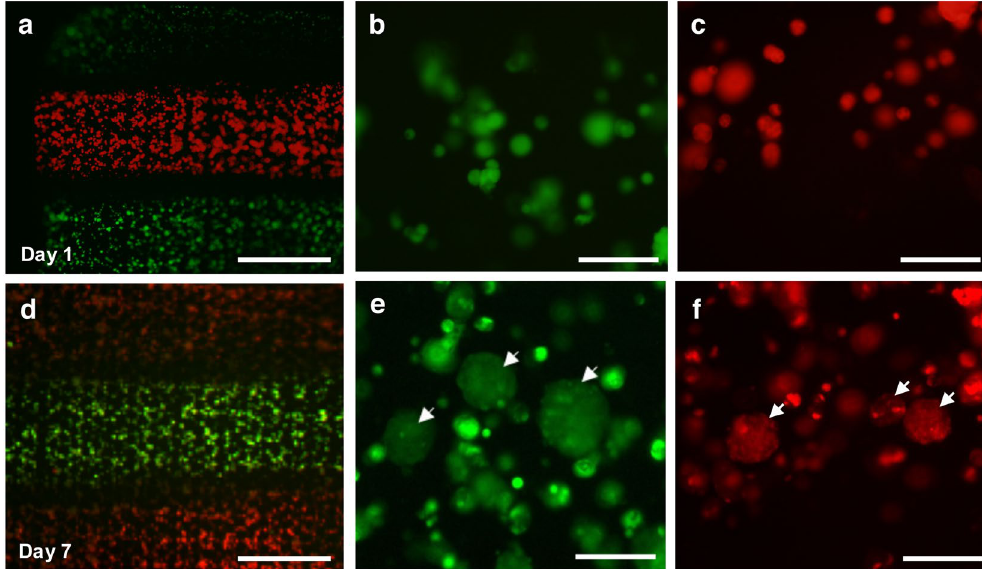
Figure 5. Demonstration of a sustainable modular sheet after the microfluidic assembly platform. ( a , d ) Encapsulated MIN6 cells in the harvested modular hydrogel sheet were partially stained and their isolated colors were maintained for an additional 7 days. Scale bar = 1 mm. Single distributed MIN6 cells ( b , c ) in the modular sheet were proliferated and cultured for 7 days and then generated into the multicellular clusters (indicated by white arrows) along the micro-sized cavities in the modular sheet ( e , f ). Scale bar = 100 µ m.